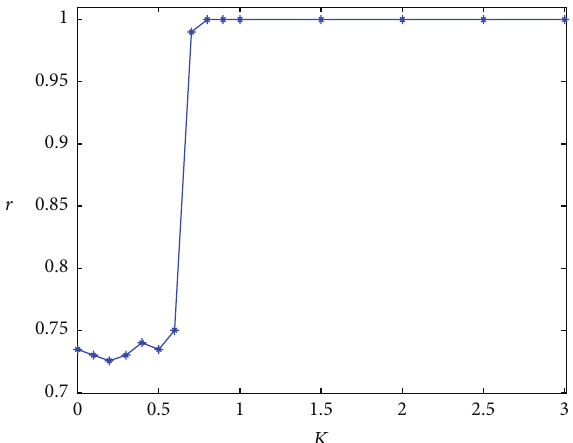
Figure 6: When group is global-coupling, the threshold 𝐾 𝑐 is about 0.6 for consensus synchronization in vent collective